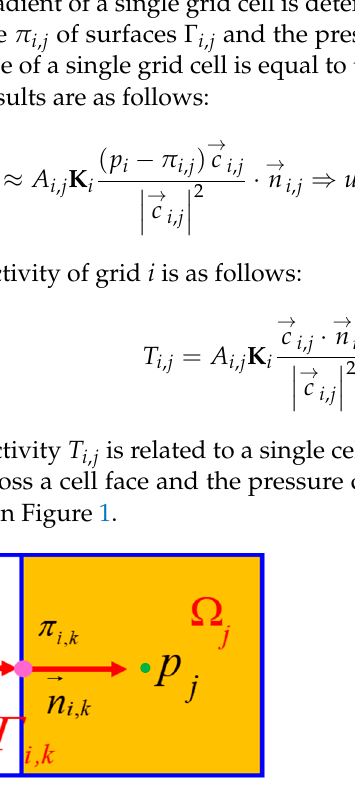
Figure 1. Two cells used to define the matrix–matrix discretization.